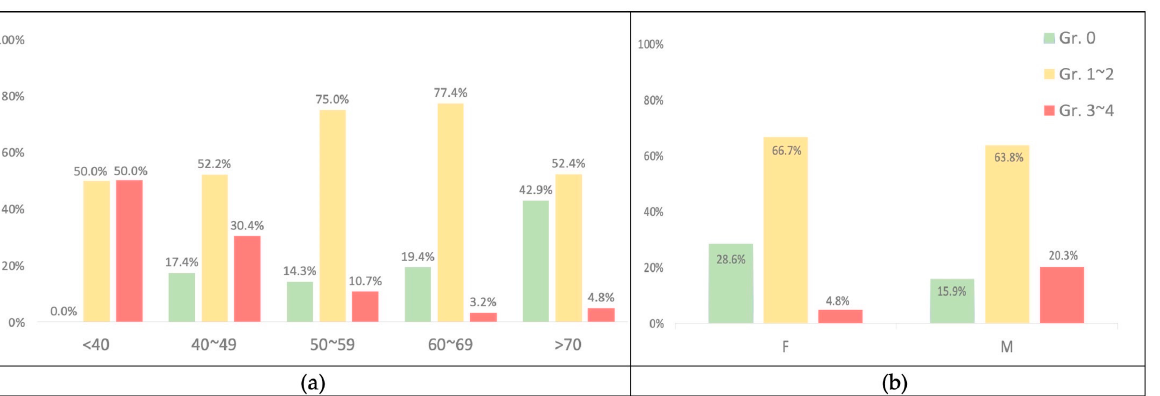
Table 6. Association between skin reactions with Age and Gender (N = 111). Variable